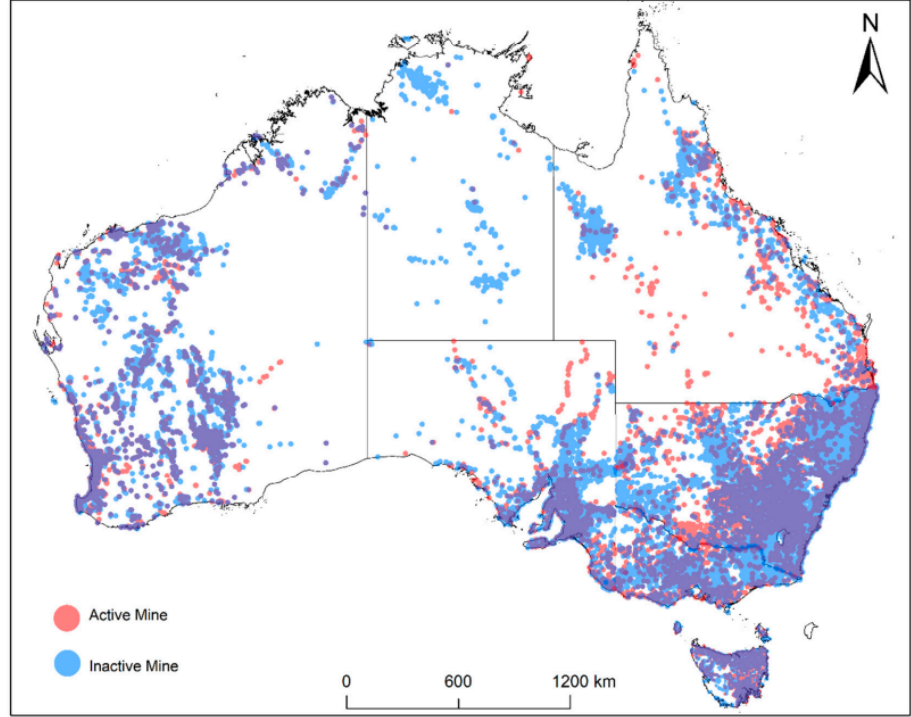
Figure 1. National overview of active and inactive mines across Australia [15].